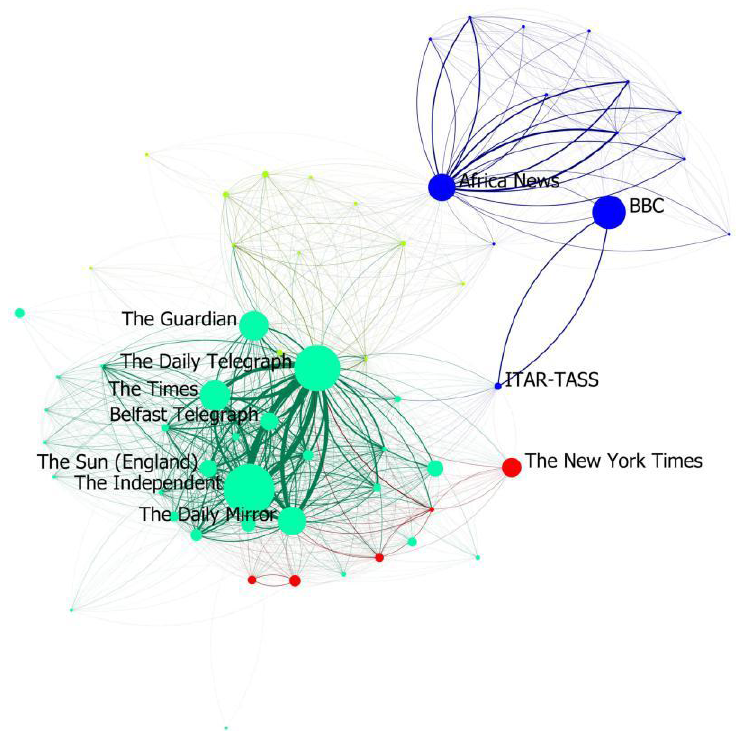
Figure 3. Thematic affiliation network for newspapers ( N = 60, 4 communities).